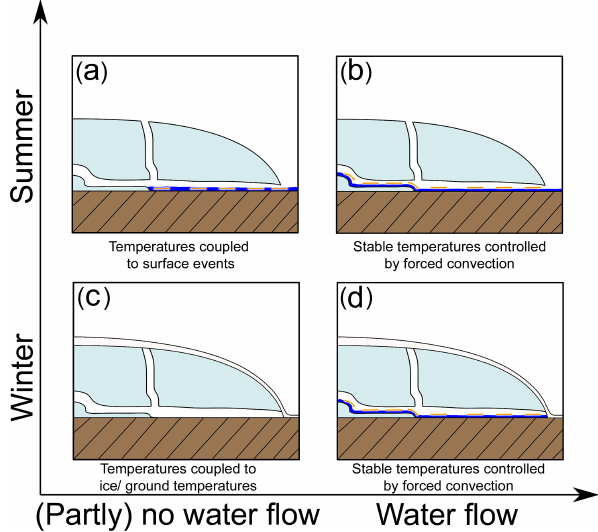
Figure 11. Proposed thermal control phases of subglacial drainage systems, with orange arrows indicating forced convection. (a) Sec- tions of subglacial drainage systems under thin ice can exhibit no water flow during parts of summer (left part of the channel indicated in the schematic). The temperatures in these water-free sections will be more fluctuating, thereby being coupled to surface events. (b) Presence of running water in the whole subglacial drainage system leads to stable temperatures in the whole system, which are con- trolled by the forced convection caused by the water. (c) Temper- atures in winter without the presence of additional running water will be less stable again, mainly dictated by the temperatures of sur- rounding ice and ground temperatures and natural convection. (d) Running water in winter will again cause forced convection, lead- ing to stable